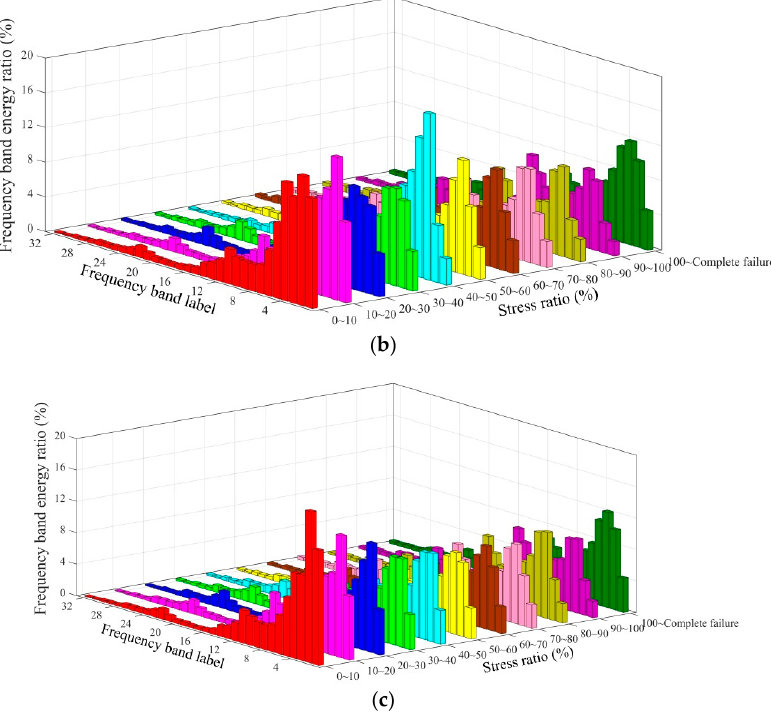
Figure 9. The 3D histogram of the band energy distribution for AE signals in each loading stress ratio interval during the entire test. ( a ) X-1 specimen; ( b ) X-3 specimen; ( c ) X-6 specimen.